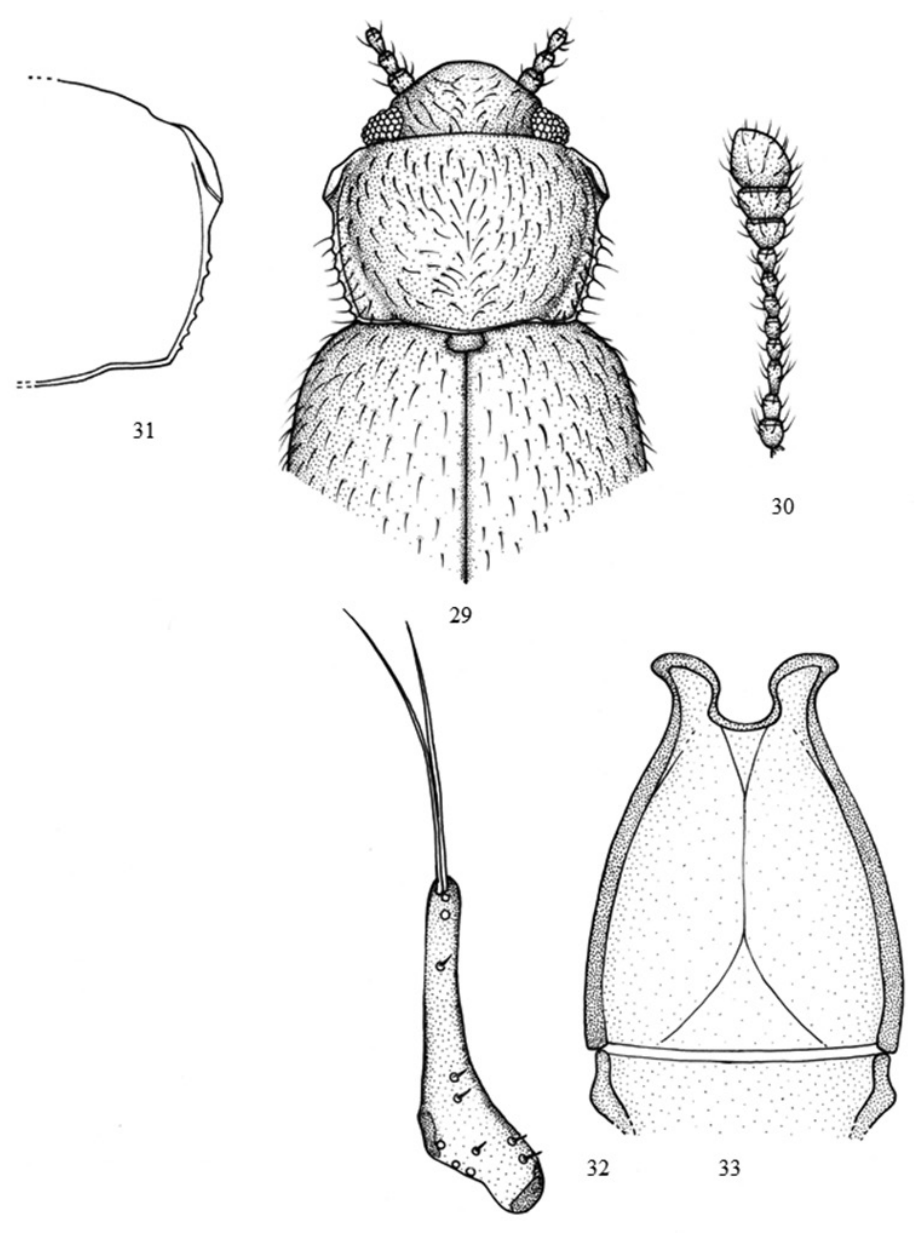
Figures 29–33. Micrambe reuninensis : 29 General view 30 antenna 31 pronotum 32 paramere 33 aedeagus (after Lyubarsky 2013, with